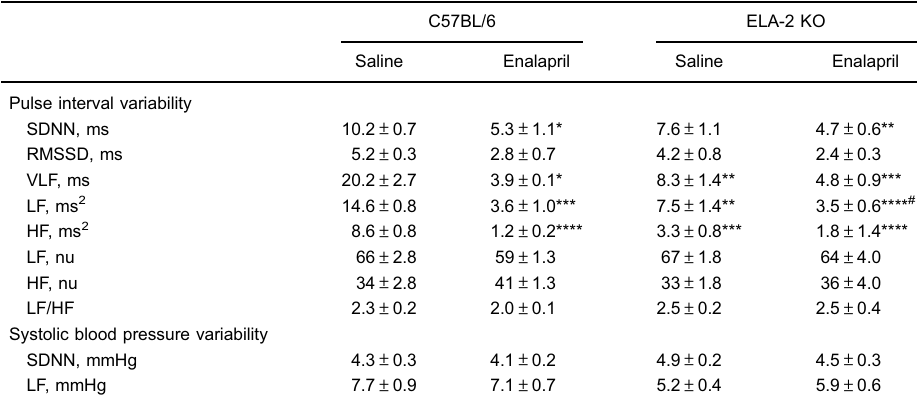
Table 1. Pulse interval and systolic blood pressure variability of C57BL/6 and ELA-2 knock-out (KO) mice 10 days after treatment with enalapril or saline.